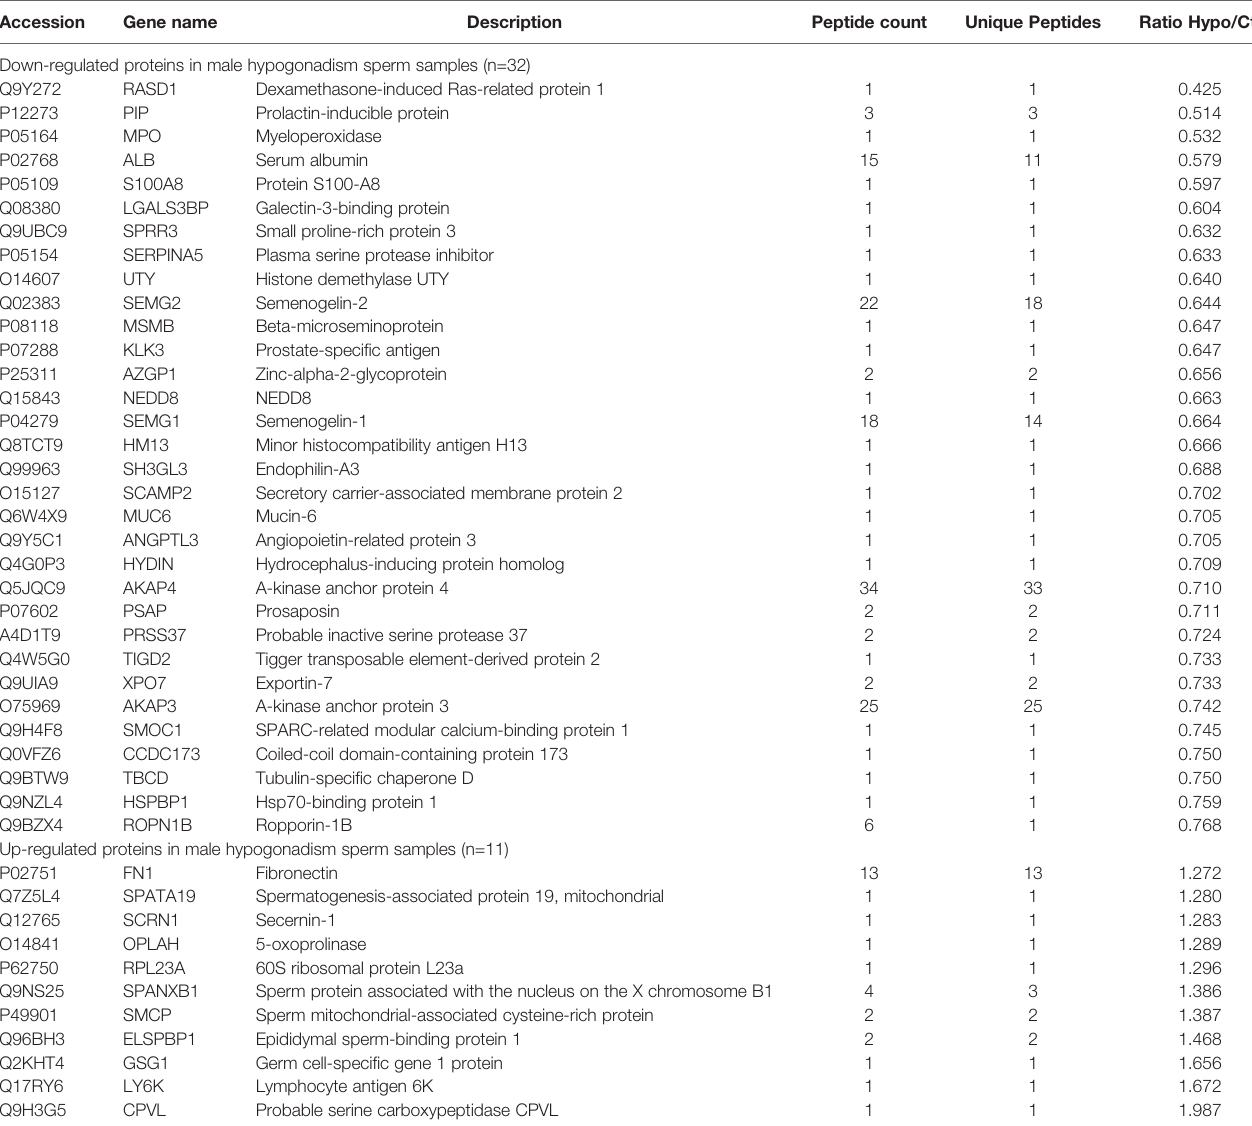
TABLE 2 | List of up-regulated and down-regulated sperm proteins in male hypogonadism (n=32 proteins down-regulated; n=11 proteins up-regulated). Accession Gene name Description Peptide